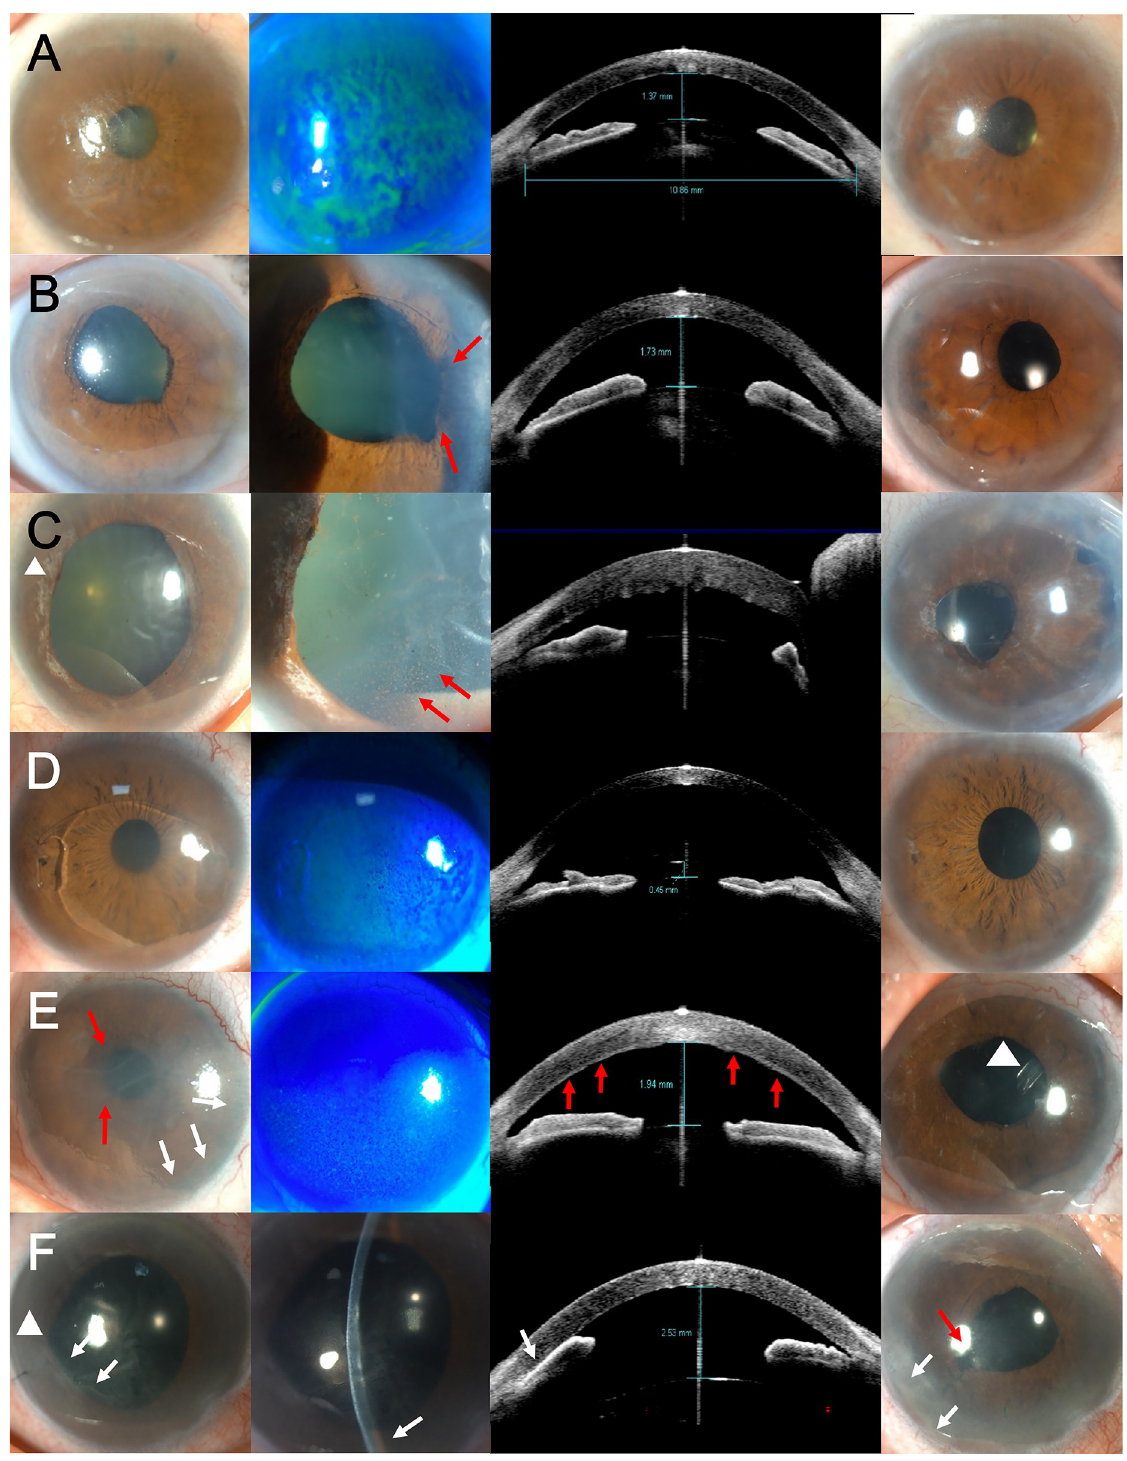
Fig 1. Representative photographs of patients with a concomitant ocular disease who underwent Descemet membrane endothelial keratoplasty (DMEK). First and second column: preoperative photographs of the cornea. Third column: horizontal (A–E) or vertical scans (F) of anterior segment optical coherence tomography. Fourth column: postoperative photographs of the cornea after DMEK. (A) Anterior displaced crystalline lens due to zonular weakness. (B) Posterior iris synechiae (red arrows) after acute angle-closure glaucoma. (C) Dilated and paralyzed pupil (white arrowhead), keratic precipitates (red arrows) and shallow anterior chamber due to acute angle-closure glaucoma.